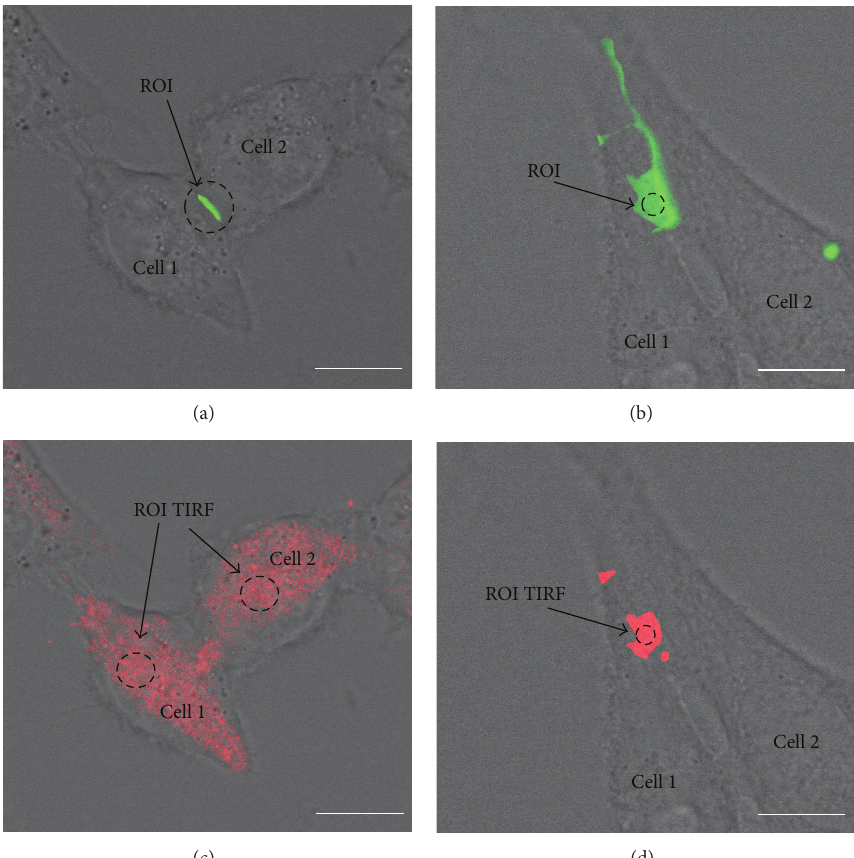
Figure 4: Measurement of Cx43-EGFP GJ channel number in JPs and hemichannel density in the plasma membrane of HeLa cells. (a) To estimate the total fluorescence of Cx43-EGFP JP (green), emitted light was integrated over the ROI encircling JP. (b) To estimate fluorescence intensity of the single Cx43-EGFP GJ channel, emitted light was integrated over the ROI situated in the horizontal JP of overlapping cells. (c) TIRF microscopy was used to estimate the density of Cx43-EGFP hemichannels (red) on the cell surface. Emitted light was integrated over the ROI situated in the site with most homogenous fluorescence. (d) To estimate the fluorescence intensity of the single Cx43-EGFP GJ hemichannel, emitted light was integrated by a TIRF microscope over the ROI situated in the horizontal JP of overlapping cells. Details are presented in the main text. Scale bar 10 𝜇